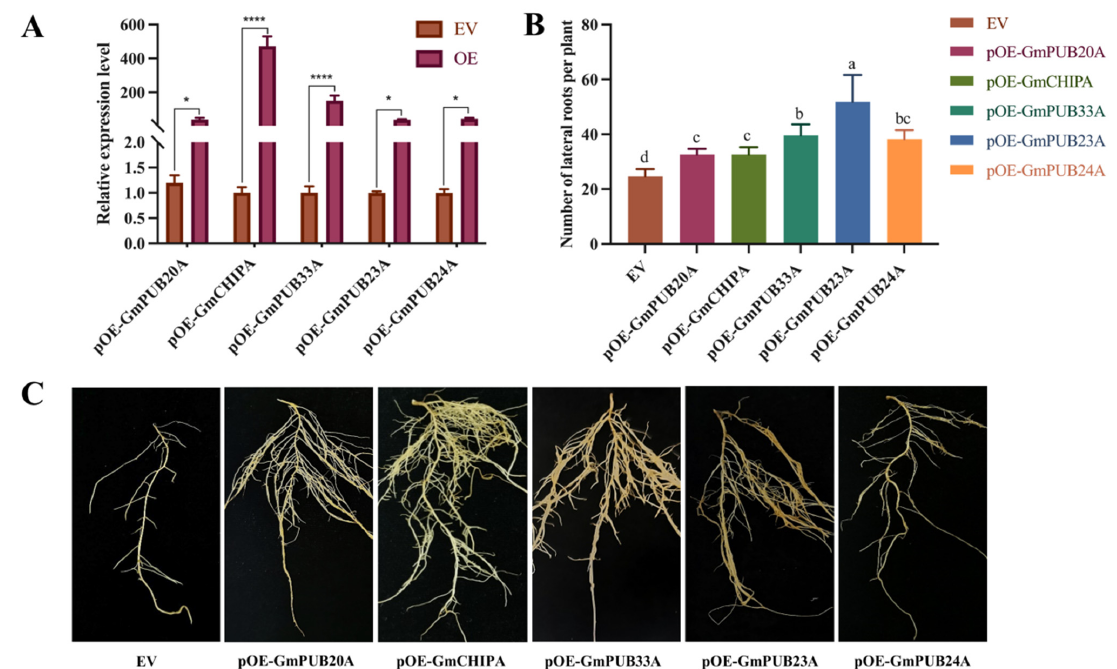
Figure 6. Expression profiles and biomass analysis of overexpression of five GmPUBs in the hairy roots. Note: ( A ), expression profiles of five GmPUBs overexpressed hairy roots, ( B ), biomass analysis of GmPUBs overexpressed hairy roots, ( C ), lateral roots of the GmPUBs overexpressed hairy roots. One-way ANOVA was applied in SPSS to analyze the difference of lateral roots in EV and transgenic hairy roots. Multiple t -tests were applied to detect the significant differences of the relative expression level of all GmPUBs in EV and other transgenic hairy roots on Graphpad prism 9. ns represent not significant. * and **** indicate significant difference at the p < 0.05 and p < 0.0001 probability level, respectively. Different characters mean significant differences found at p < 0.05 level.